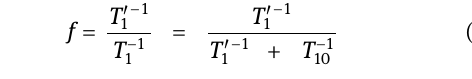
Figure 1: Diagram showing the energy level of a nucleus that has a 1/2 - spin and two - spin electron system. m I and m S denote the magnetic quantum numbers of nucleus and electron, respectively. ω i and w i ( i = 0, 1, 2 ) represent the transition frequencies and probabilities. Here ω S / ω I equals to 700 for 19 F nucleus.